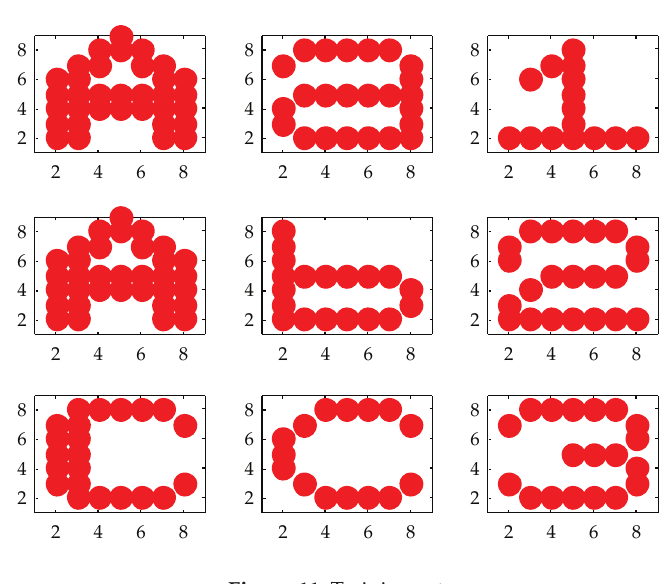
Figure 11: Training